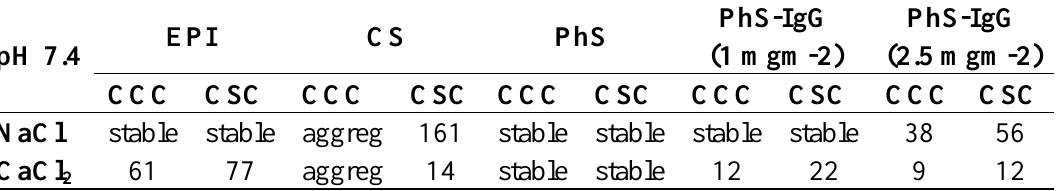
as aggregating 2